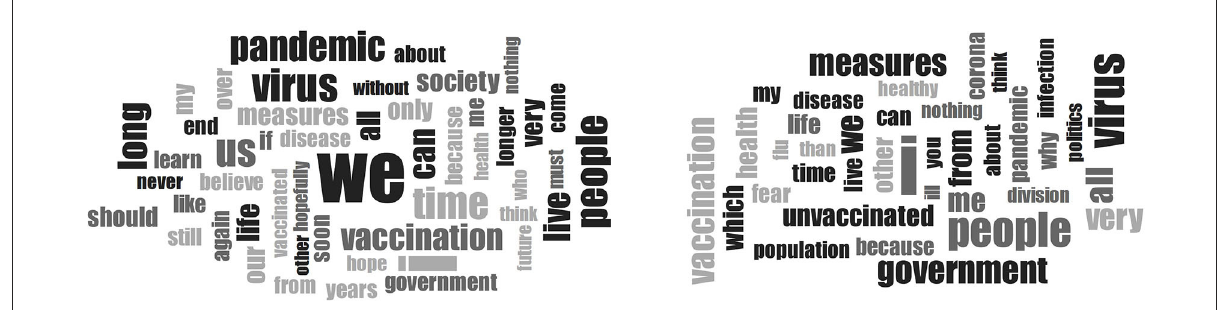
FIGURE1 Word clouds of item 1 (“When I think about the COVID-19 pandemic, I believe”) of vaccinated vs. unvaccinated workers in the healthcare